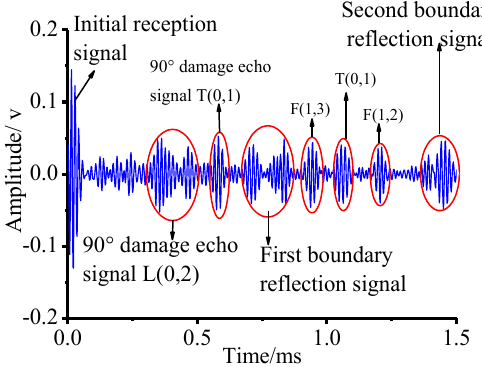
Figure 25. The received signal for the pipe with circumferential damage of 90° in the experiment.